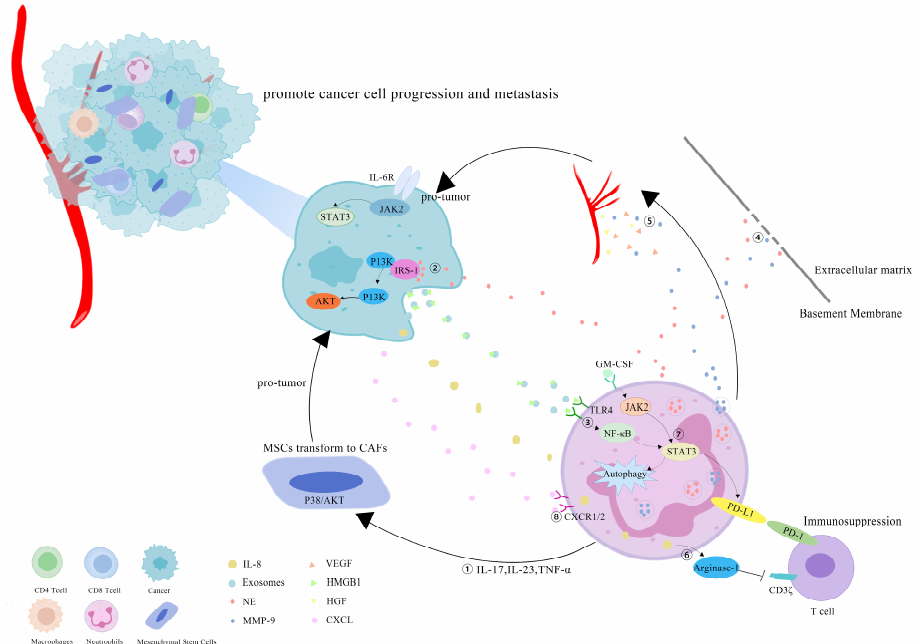
Figure 1. Mechanisms of TANs that promote tumor progression: (1) TANs secrete cytokines, such as IL-17, IL-23 and TNF- upalpha , to induce MSCs to convert into CAFs, and to promote tumor-cell proliferation; (2) TANs secrete NE to bind intracellular IRS-1, releasing its inhibitory effect on the PI3K/Akt pathway, and promoting tumor proliferation; (3) cell-derived exosomes induce the autophagy and N2 polarization of neutrophils via HMGB1/TLR4/NF- κ B signaling to promote cancer-cell proliferation and migration; (4) TANs secrete NE and MMP-9 to degrade the ECM and accelerate the tumor invasion; (5) TAN-derived VEGF, HGF and MMP9 promote the angiogenesis of tumor cells; (6) tumor-derived IL-8 induces neutrophils to secret arginase-1, resulting in arginase depletion and the establishment of an immunosuppressive TME; (7) GM-CSF activates TANs to express high levels of the immunosuppressive molecule PD-L1 through the JAK2/STAT3 signaling pathway; (8) neutrophils can be recruited by tumor cells through chemokines, such as the CXCL/CXCR1/2 signal axis.